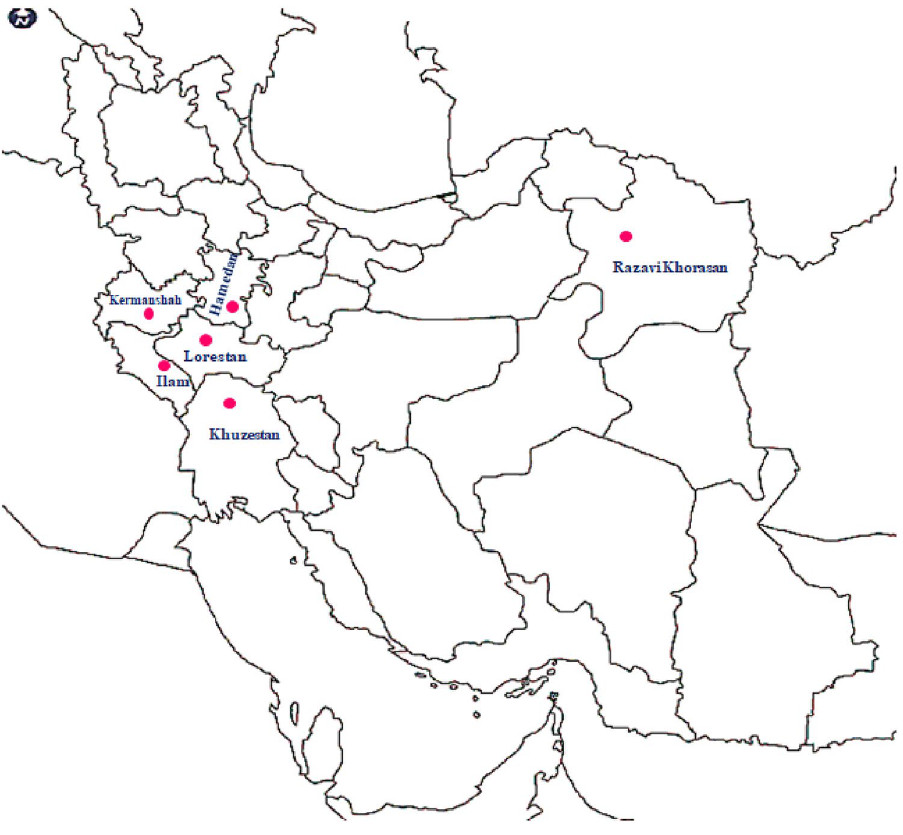
Figure 4. The provinces where the Anemone accessions were collected and their locations in Iran. The total area of the country: 1.648 million km 2